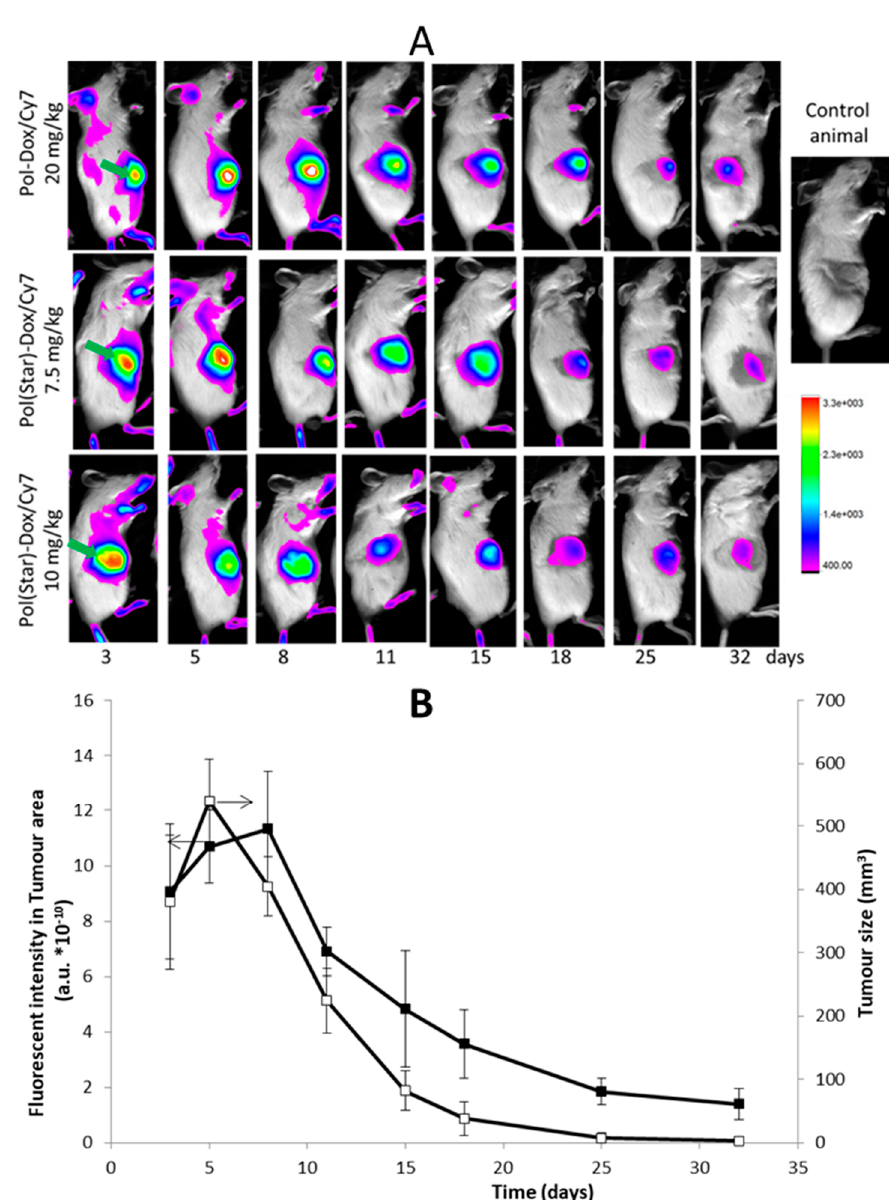
Figure 10. ( A ) In vivo optical imaging. Serial in vivo optical imaging of RAJI tumour-bearing mice injected with linear polymer Pol-Dox / Cy7 (dose 20 mg Dox eq. / kg), star polymer Pol(Star)-Dox / Cy7 (dose 7.5 and 10 mg Dox eq. / kg) at 3, 5, 8, 11, 18, 25, and 32 days intraperitoneally. Green arrows indicate the position of RAJI tumours; ( B ) comparison of the fluorescent intensity in the tumor area (left axis) and tumor size measured by the caliper (right axis) for treatment of RAJI-based xenografts with Cyanine7-labelled star-like HPMA-based polymer conjugates with Dox in the dose 7.5 mg / kg. The conjugate was administered i.p. at day 1, when all mice developed palpable s.c. tumors; ( □ ── ) tumor size; ( ■─ ─ ) fluorescent intensity in tumor area. (Reprinted with permission from [97], Copyright [2017], Elsevier.